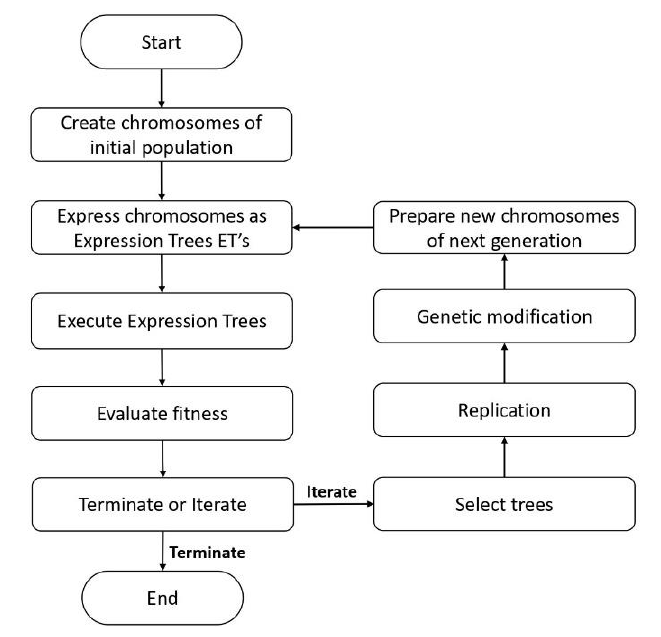
Figure 4. Steps involved in developing the algorithm of GEP.